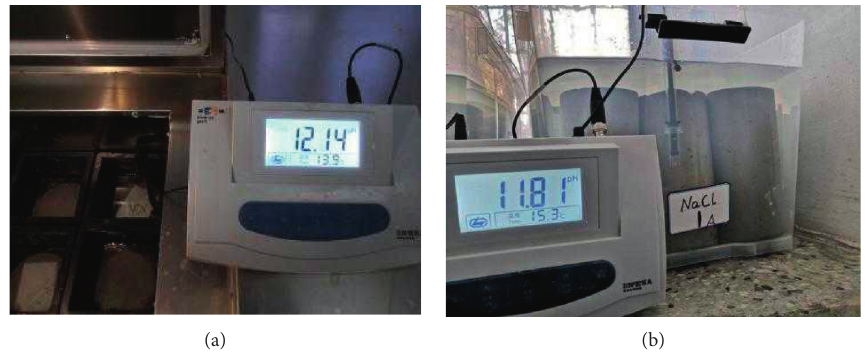
Figure 6: Measuring the PH. (a) Freeze-thaw cycle environment. (b) Solution immersion environment.